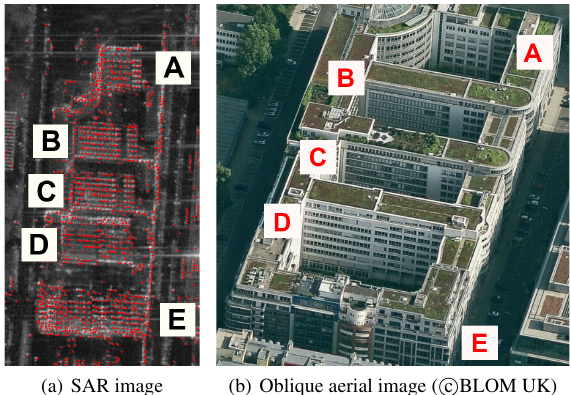
Figure 1: A building complex in the city center of Berlin in a SAR and oblique optical image. The regular facade patterns can be seen in both data